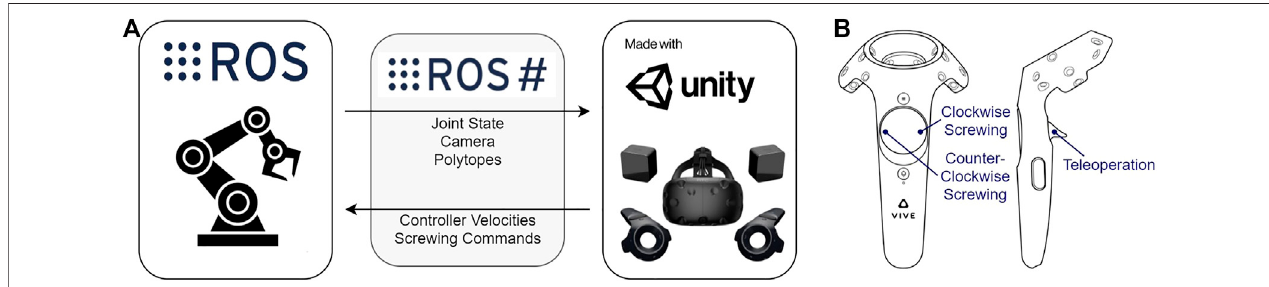
FIGURE 3 | Diagram of the HTC Vive virtual reality system and handheld controller interface. (A) The entire virtual reality architecture is built along a ROS# communication bridge that transfers data between the robot ( e.g., joint state information) and Unity application ( e.g., command velocities). (B) Handheld controller with button functions to engage in teleoperation and screwing.